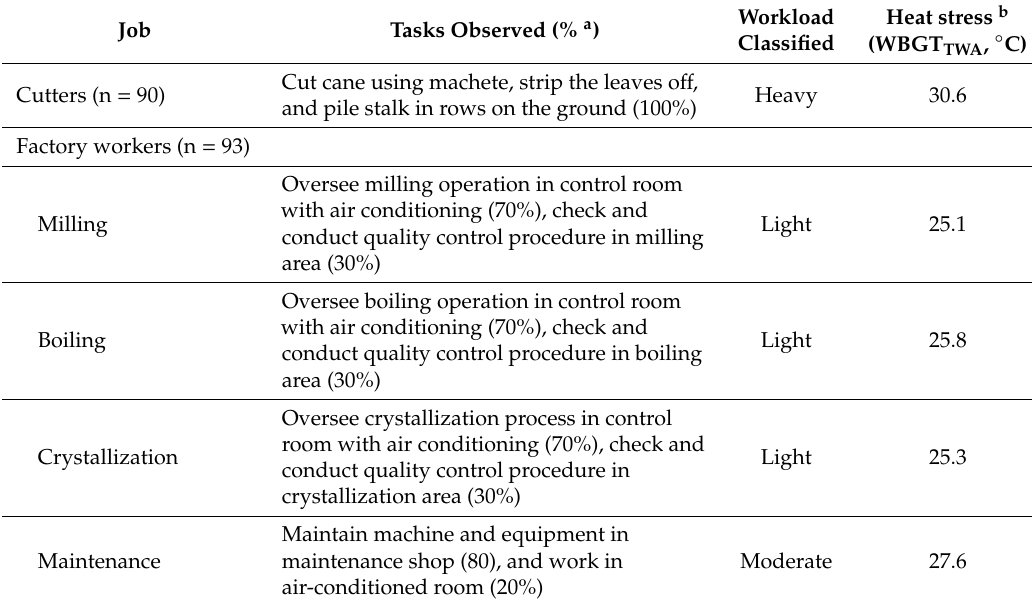
Table 3. Classification of workload and heat exposure for sugarcane